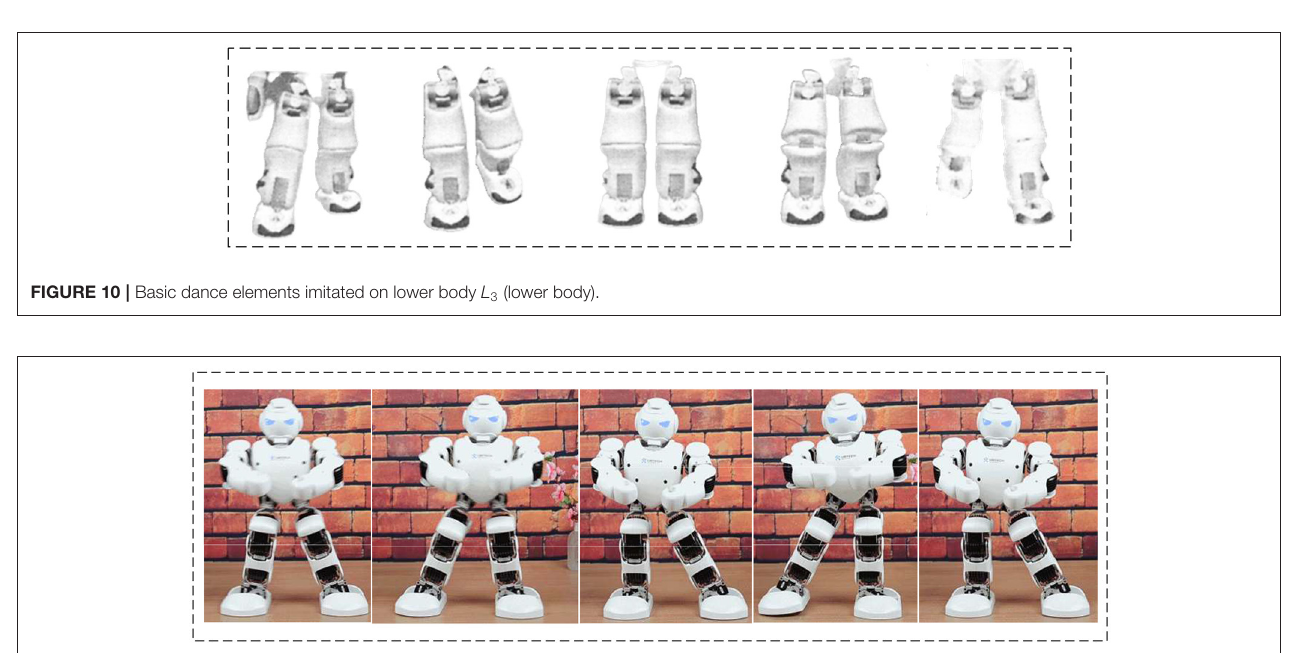
FIGURE 11 | An “Excellent” dance posture imagined by the humanoid